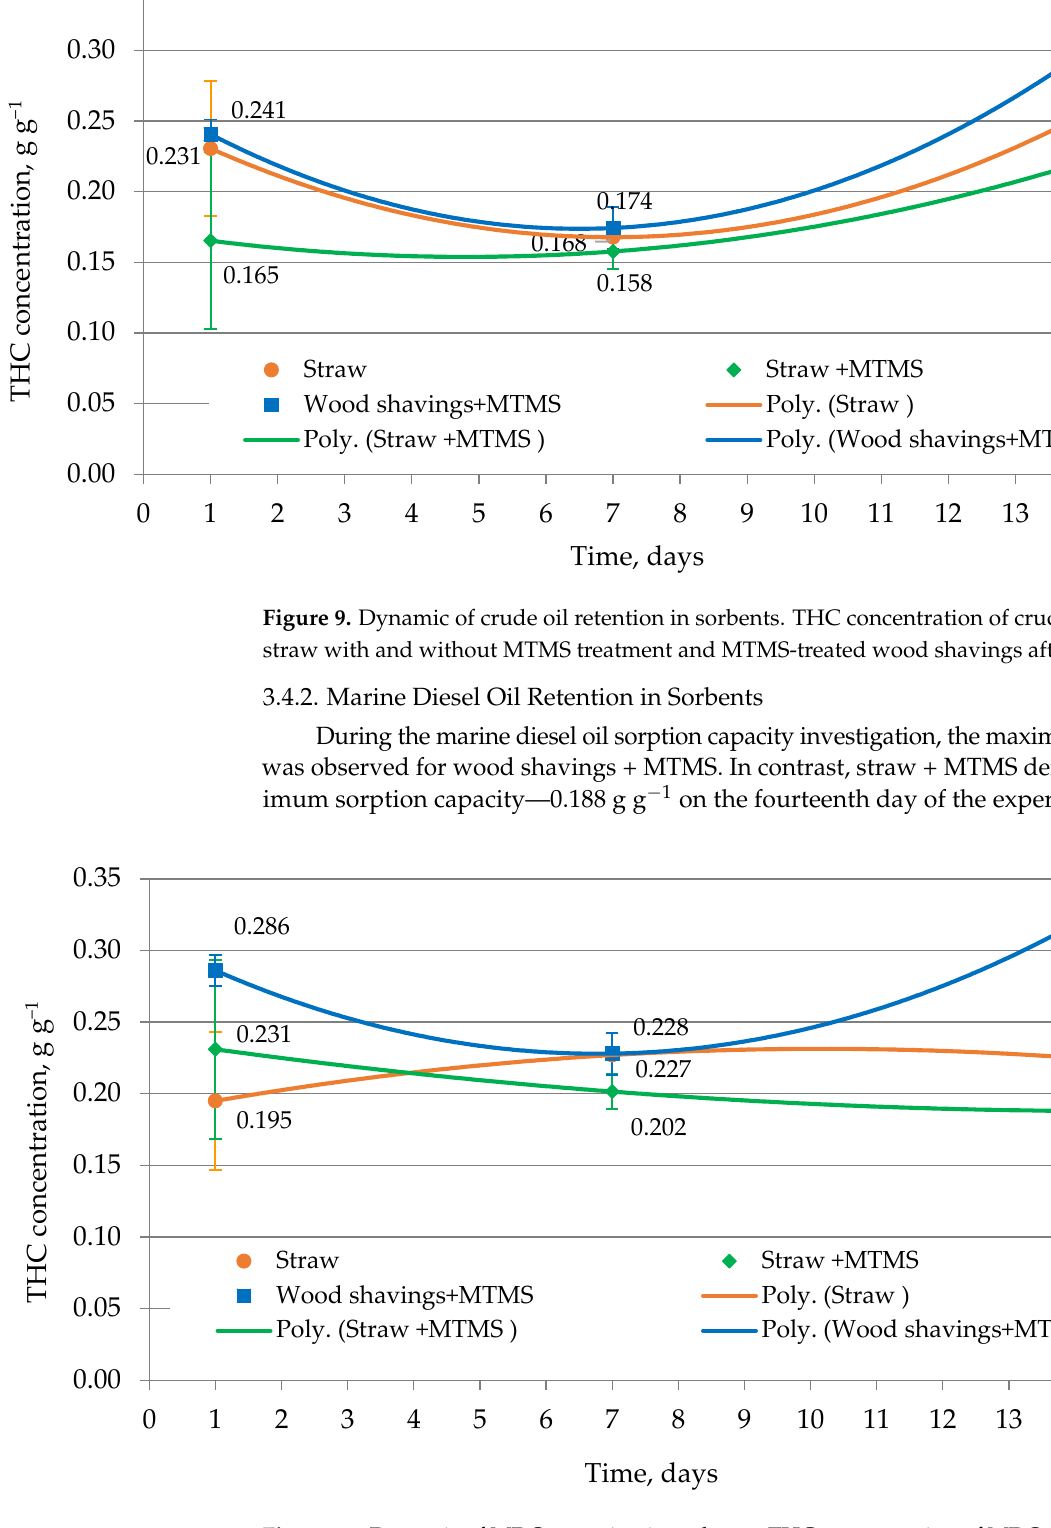
Figure 10. Dynamic of MDO retention in sorbents. THC concentration of MDO in the sorbent straw with and without MTMS treatment and MTMS-treated wood shavings after 1, 7 and 14 days. Concerning the results of the MDO retention in the sorbents, it was noted that the sorption capacities of wood shavings + MTMS increased from the 1st to 14th day by 11.5%. A possible explanation for the decrease in sorption capacity after 7 days could be the com- plex internal morphology typical of natural materials. The MDO is absorbed by the wood shavings and is not measurable within the extraction time. However, in the course of the